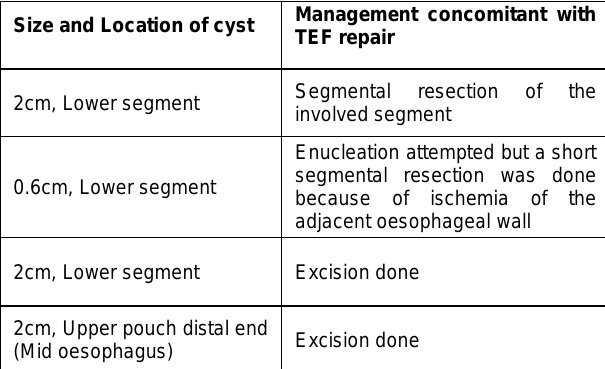
Table 1: Summary of cases managed at the time of primary